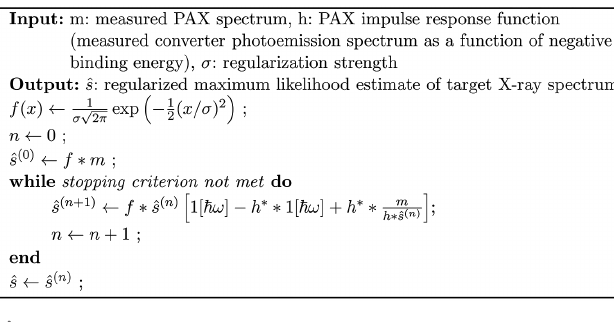
Figure 6 Algorithm 1: regularized deconvolution of PAX data.